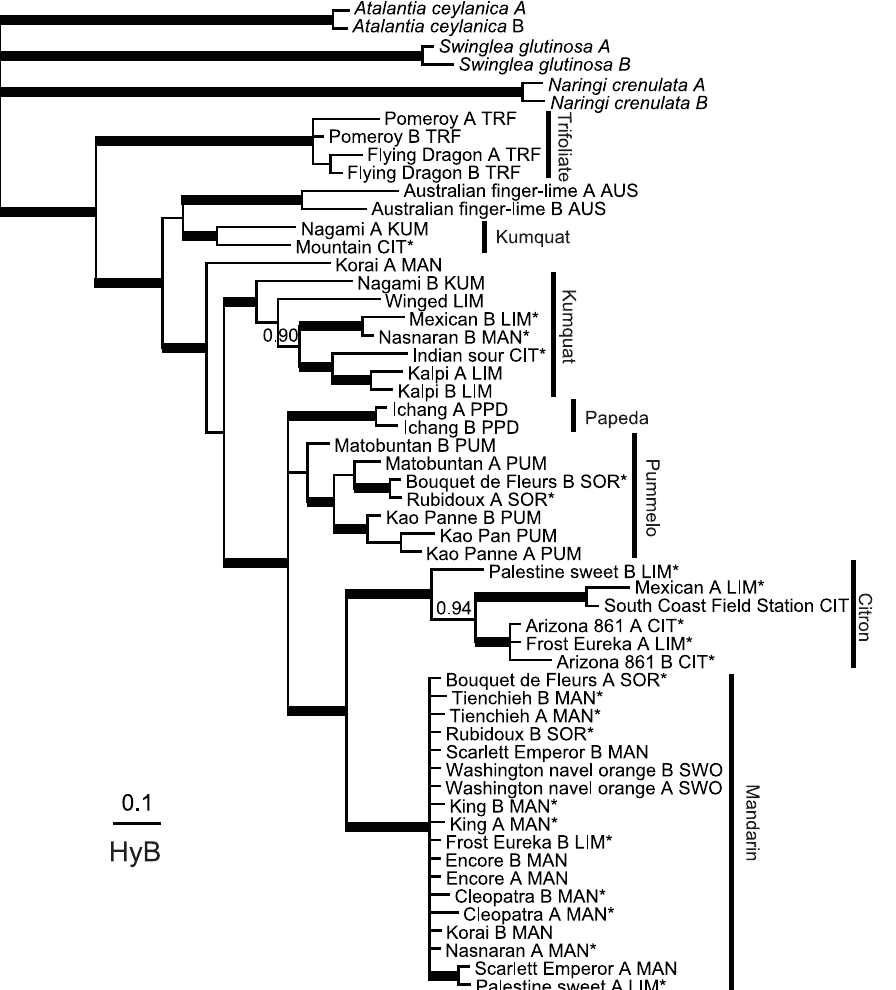
Figure 1. Bayesian consensus phylogram of HYB sequences from Citrus and related genera. Clades with posterior probabilities (PP) of 0.95–1.00 are marked with bold branches; clades with PP less than 0.95 but at least 0.90 are shown above or to the left of branches. Accessions belonging to Citrus, Poncirus, Fortunella and Microcitrus are indicated by cultivar or common names with details in Table 1. Latin names are used for outgroup genera only. Suffix A and B refer to the two haplotypes. Accessions without a suffix have only one haplotype. The traditional cultivar group to which the accession was previously assigned is indicated by three letter abbreviation following the cultivar/haplotype information. The abbreviations used are: CIT: citron; MAN: mandarin; PUM: pummelo; TRF: trifoliate orange; SWO: sweet orange; KUM: kumquat; SOR: sour orange; PPD: papeda; LIM: lime and lemon. Groups of alleles discussed in the text are marked by cultivar grouping names on the right. Cultivars that indicated an admixture of more than 10% (Table S6) are marked by an asterisk. Scale bar for branch lengths represents substitutions per